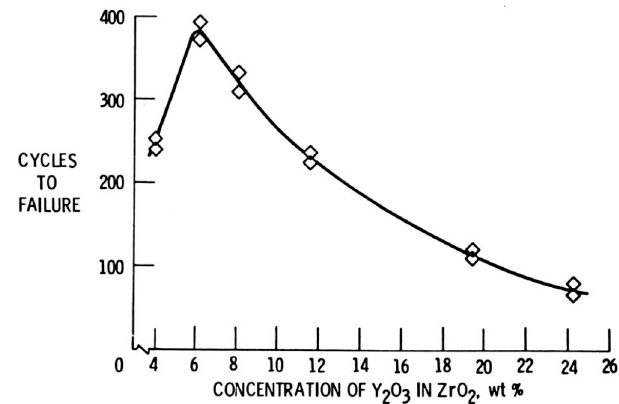
Figure 2. TBC life (time to first TBC crack) in 1110 ° C 1-h cyclic furnace test as a function of Y 2 O 3 content in YSZ; Ni-16Cr-6Al-0.2Y bondcoat [13].